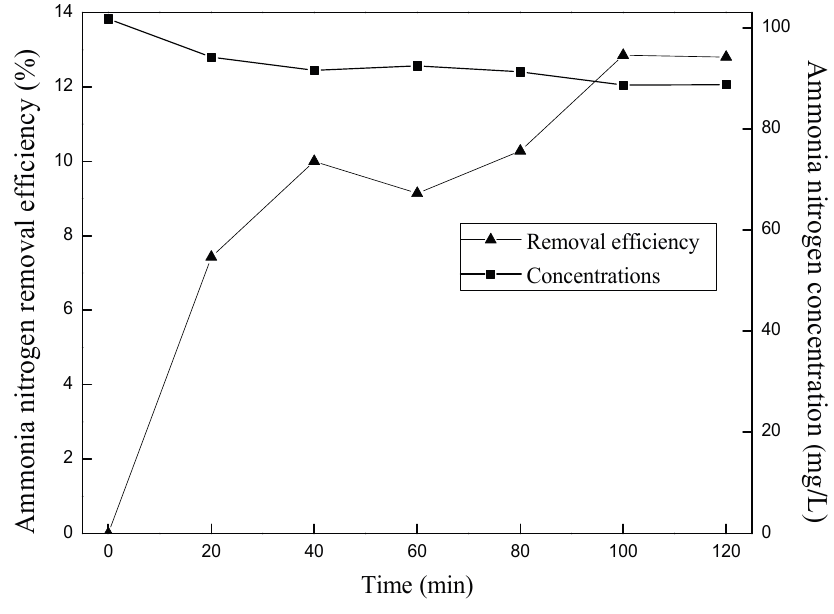
Figure 2. Curves of blank stripping over 3L/min air